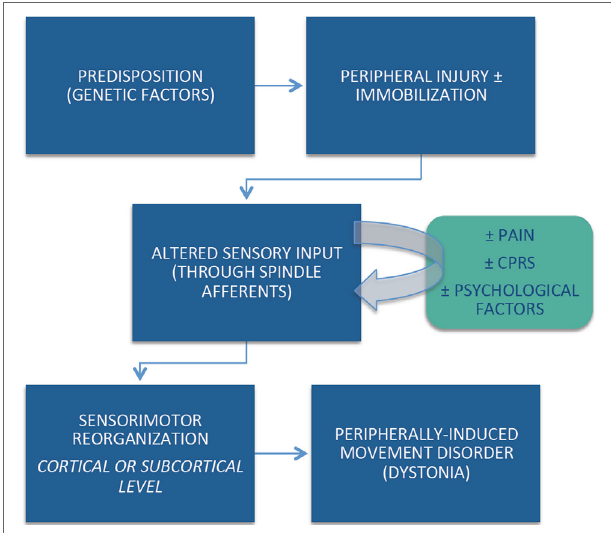
FiGURe 1 | Diagram of hypothesis of peripherally induced movement disorders